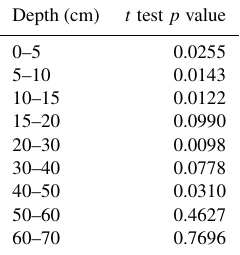
Table D3. We use p values from Student’s t test to compare the C : N ratio between vine and forest soils. Up to 50cm depth, the p values were under 0.05, except for the 15–20 and 30–40cm horizons where they were less than 0.1. This result shows that there was a significant difference in C : N, with lower values in the vineyard than in the forest soils. This result tended to confirm that, at equivalent depth, the C pool remaining in the vineyard had a more marked microbial signature than the C pool in the forest